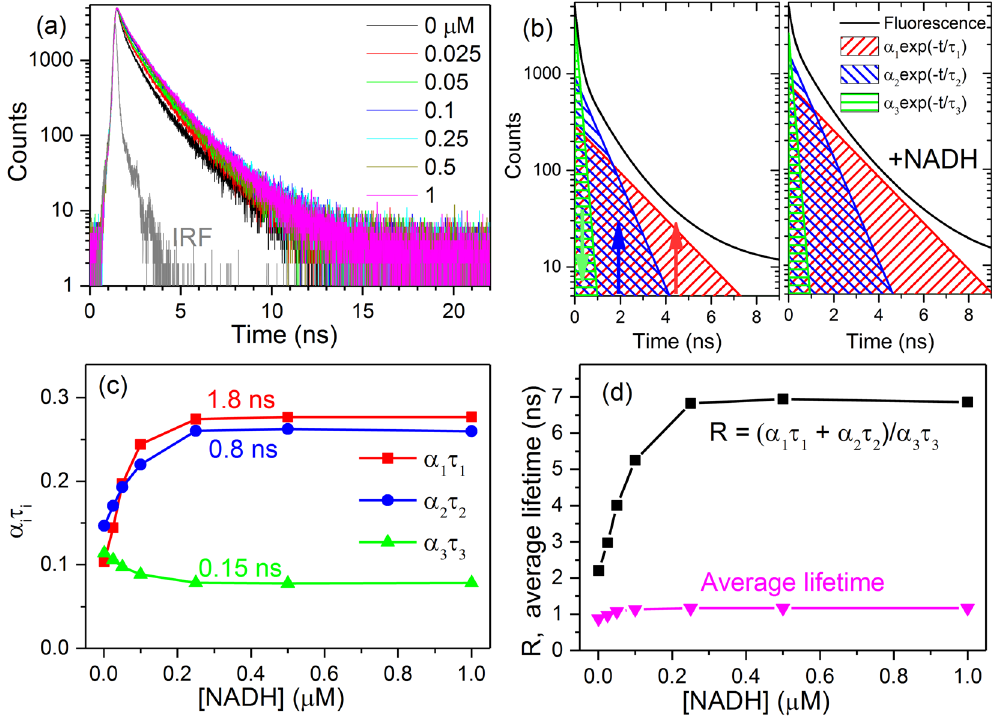
Figure 4. Time-resolved fluorescence of SoNar in the NADH concentration titration experiment. ( a ) Time- resolved fluorescence decay curves of SoNar (0.2 μ M) in the presence of various NADH concentrations. The fluorescence of SoNar was excited at 420 nm and detected at 512 nm. Figure ( b ) shows the reconstructed tri- exponential and the corresponding mono-exponential decay curves of the time-resolved fluorescence decay profiles measured in the absence of NADH (left panel) and in the presence of 1.0 μ M NADH (right panel), respectively. ( c ) Fractional intensities ( α i τ i ) of SoNar versus NADH concentrations. ( d ) Ratio of fractional intensities ( α τ α τ α τ = + R ( )/ ) and the average lifetime of SoNar versus NADH 1 1 2 2 3 3